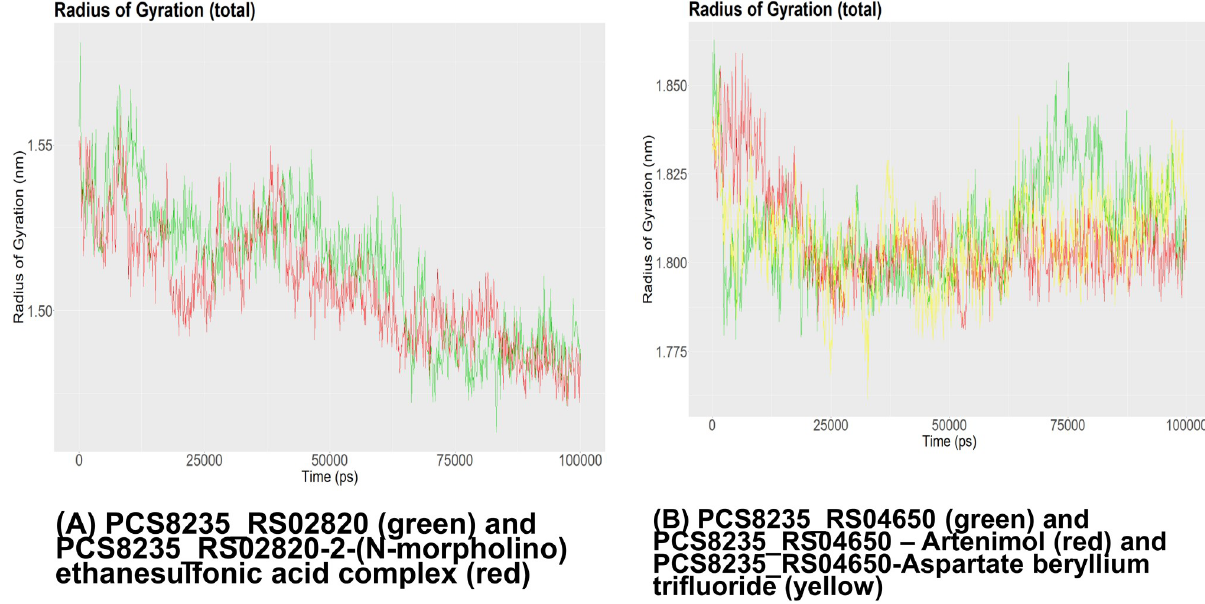
Fig 10. Rg measurement of (A) PCS8235_RS02820 (green) and PCS8235_RS02820-2-(N-morpholino) ethanesulfonic acid complex (red) (B) PCS8235_RS04650 (green) and PCS8235_RS04650 –Artenimol (red) and PCS8235_RS04650-Aspartate beryllium trifluoride (yellow) at 100 ns.